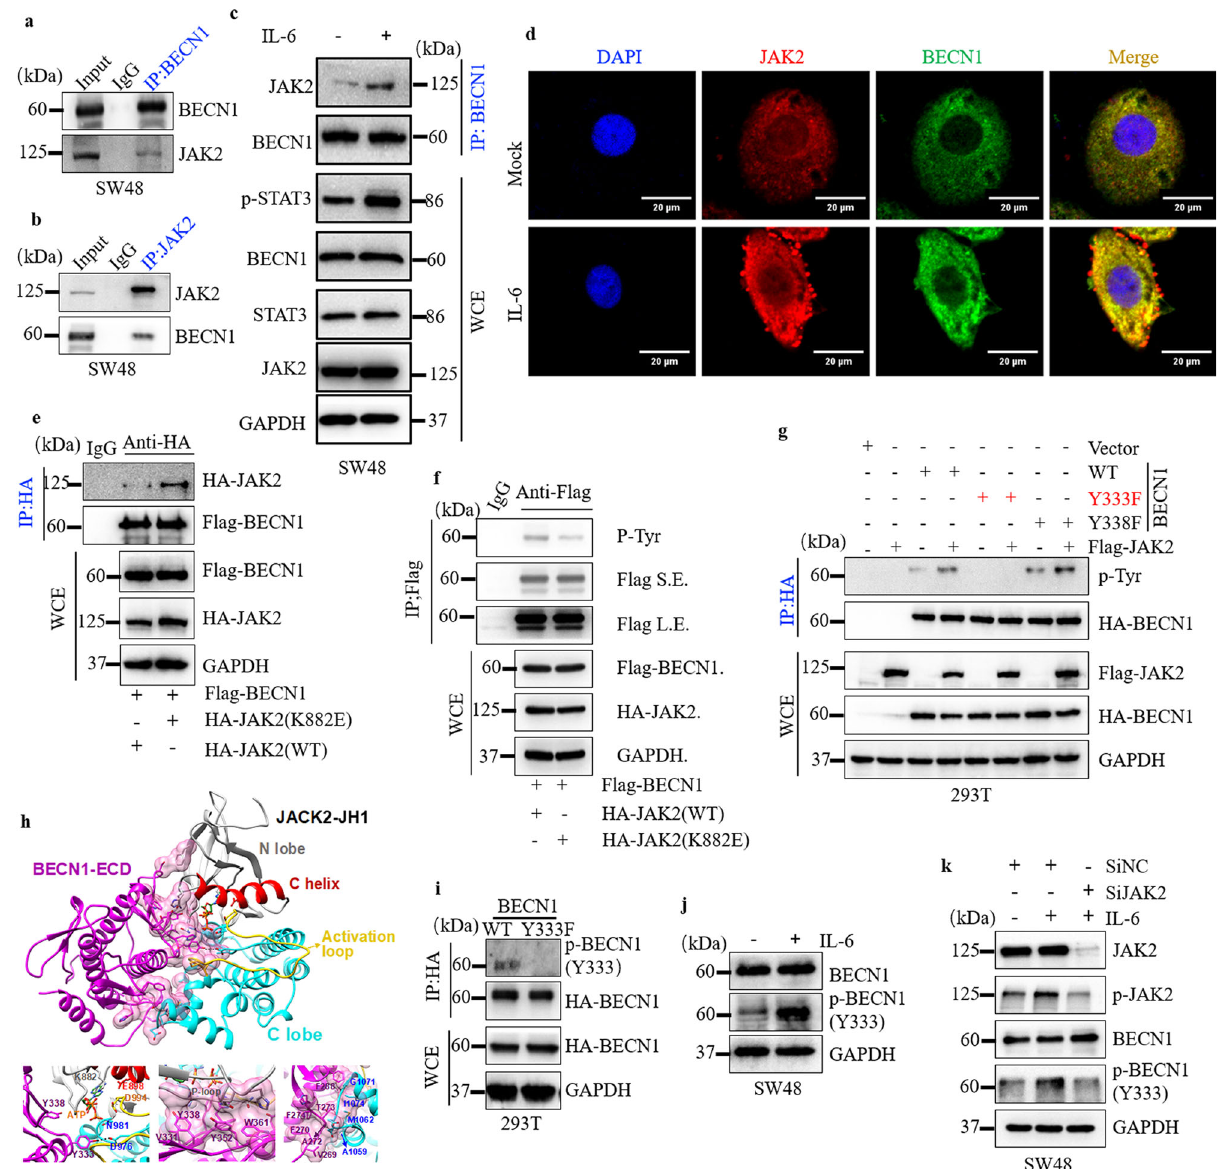
Fig. 3 JAK2 interacts with BECN1 and phosphorylates BECN1 at Y333. a , b Immunoprecipitation (IP) analyses were performed to examine the interaction between BECN1 and JAK2 ( a ) or JAK2 and BECN1 ( b ) in SW48 cells. c Co-IP was performed to examine the relationship between JAK2 and BECN1 in SW48 cells in the absence or presence of IL-6 (20 ng/ml) for 12 h (upper panels). Western blotting was performed on whole-cell extracts (WCEs) (lower panels). d Immuno fl uorescent staining (IF) analyses of LoVo cells using anti-BECN1 and anti-JAK2 antibodies. Yellow puncta, double-stained BECN1 and JAK2. Scale bars, 20 μ m. e Co-IP was performed to examine the interaction of JAK2 and BECN1 in HEK293T cells cotransfected with Flag-BECN1 and HA- JAK2 (WT)/HA-JAK2 (K882E) (upper panels) for 24 h. Western blotting was performed on WCEs (lower panels). f Co-IP was performed to examine the tyrosine phosphorylation of Flag-BECN1 in HEK293T cells cotransfected with Flag-BECN1 and HA-JAK2 (WT)/HA-JAK2 (K882E) (upper panels) for 24 h. Western blotting was performed on WCEs (lower panels). g Co-IP analyses for HA-BECN1 and p-Tyr in HEK293T cells expressing Flag-JAK2, a vector control (Vector), HA-BECN1 WT, HA-BECN1 Y333F, or HA-BECN1 Y338F. Western blotting was performed on WCEs (lower panels). h Modeled complex structure between the ECD domain (magenta, left) and JH1 domain (right), where the JH1 domain consists of four regions: an N-terminal lobe (gray), a C- terminal lobe (cyan), a C helix (red), and an activation loop (yellow). ATP is colored by element, with carbon atoms in green, oxygen atoms in red, nitrogen atoms in blue, and phosphorus atoms in orange. The residues involved in the hydrophobic interaction are shown in pink sphere representation, with atoms shown as sticks. The hydrogen bond is shown by black dashed lines. On the bottom, from left to right, are the enlarged images for the interface in the catalytic site, the interface between the β sheet with the phosphorylation site of the ECD domain and the N-terminal lobe of the JH1 domain, and the interface between the hydrophobic loop of the ECD domain and the C-terminal lobe of the JH1 domain, respectively. i IP analyses for HA-BECN1 and p- BECN1 (Y333) in HEK293T cells expressing HA-BECN1 WT or HA-BECN1 Y333F. Western blotting was performed on WCEs (lower panels). j Western blotting was performed to examine the expression of BECN1 and p-BECN1 (Y333) in LoVo cells in the absence or presence of IL-6 (20 ng/ml) for 12 h. k SW48 cells were separately transfected with SiJAK2 and SiNC. After transfection for 48 h and following stimulation with IL-6 (20 ng/ml) for 12 h, western blotting was performed. Western blots are representative of two independent experiments. WCE whole-cell extract. Source data are provided in the Source Data fi